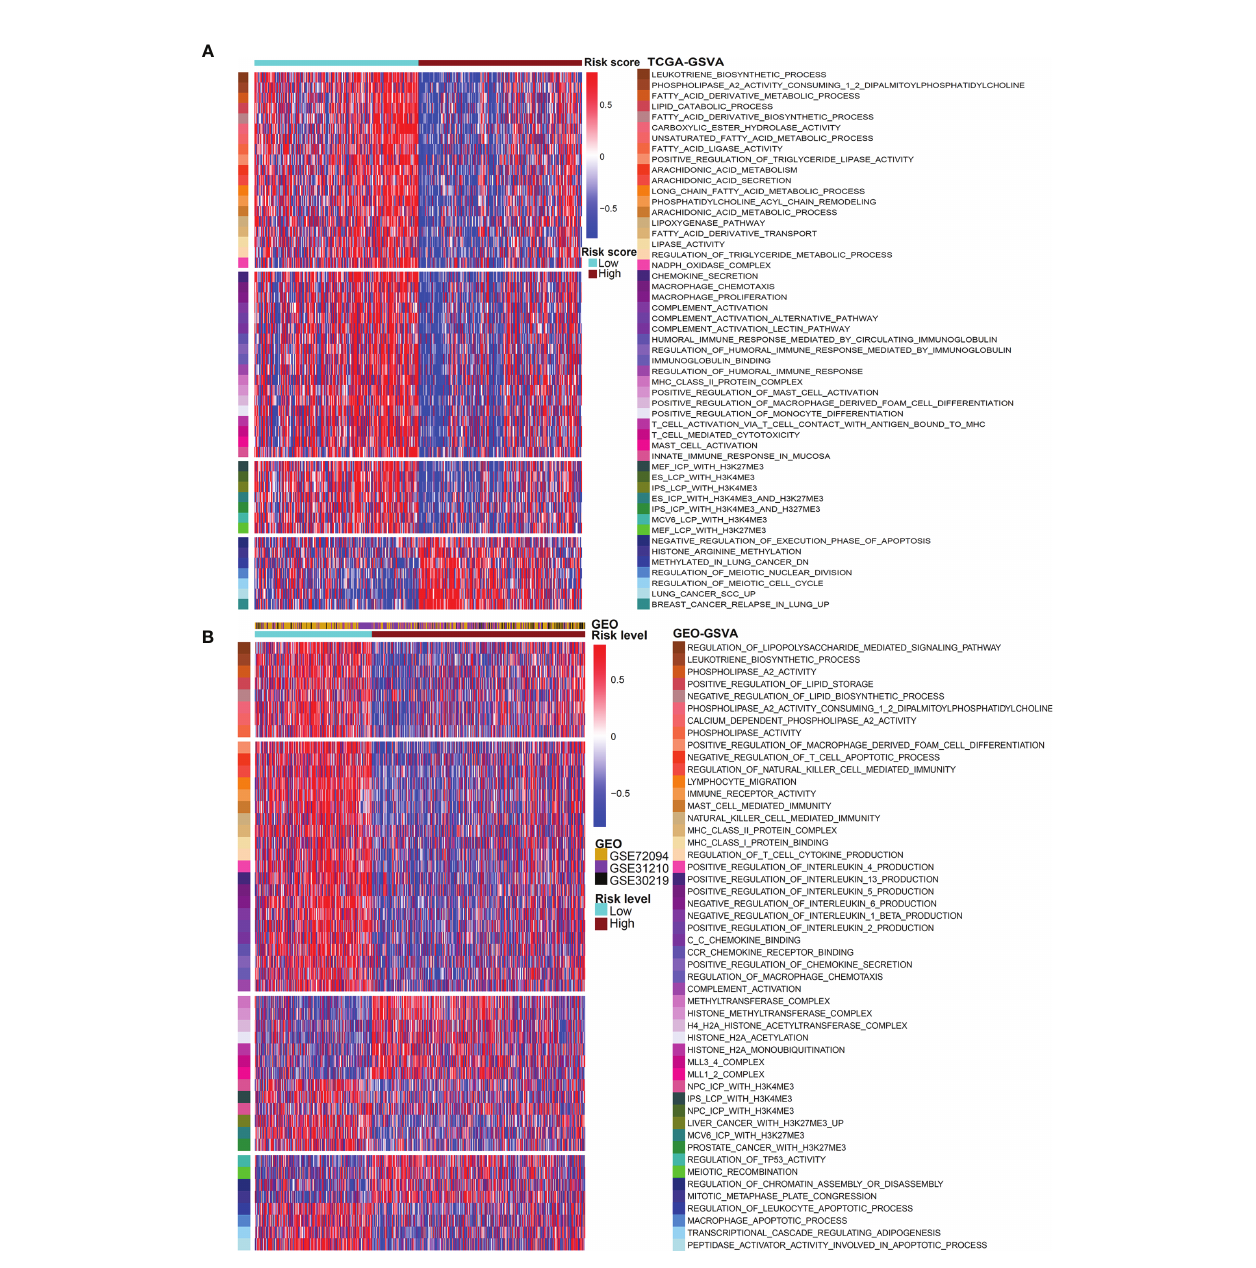
FIGURE 5 | GSVA analysis for the two risk patterns. Heatmap visualizing these most important biological pathways in distinct risk patterns based on TCGA dataset (A) and GEO dataset (B) . Blue indicates repressed pathways, and red represents activated